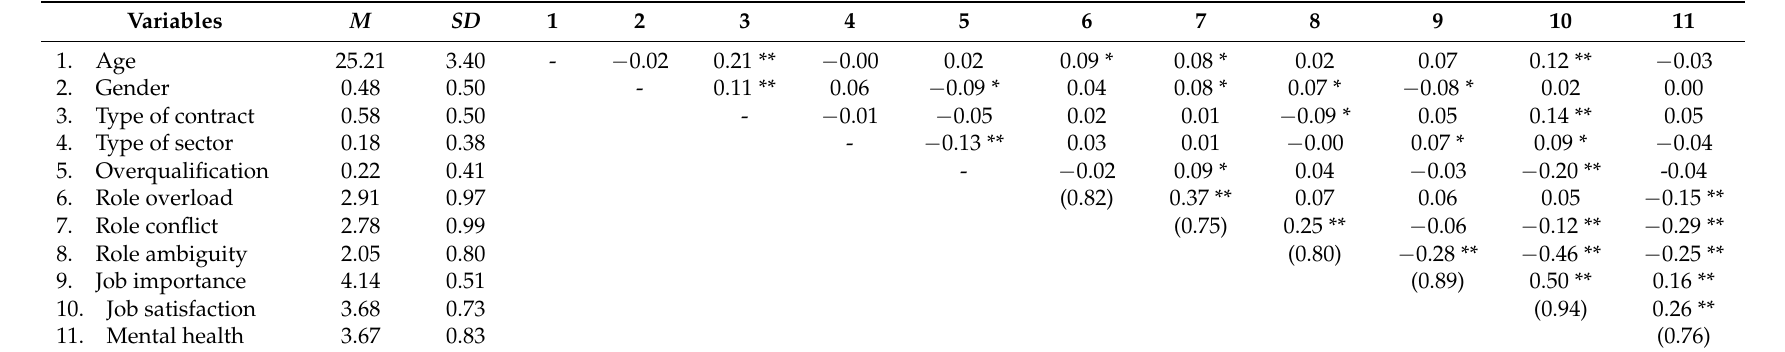
Table 1. Bivariate correlations and descriptive statistics of the job satisfaction-mental health pattern predictors.